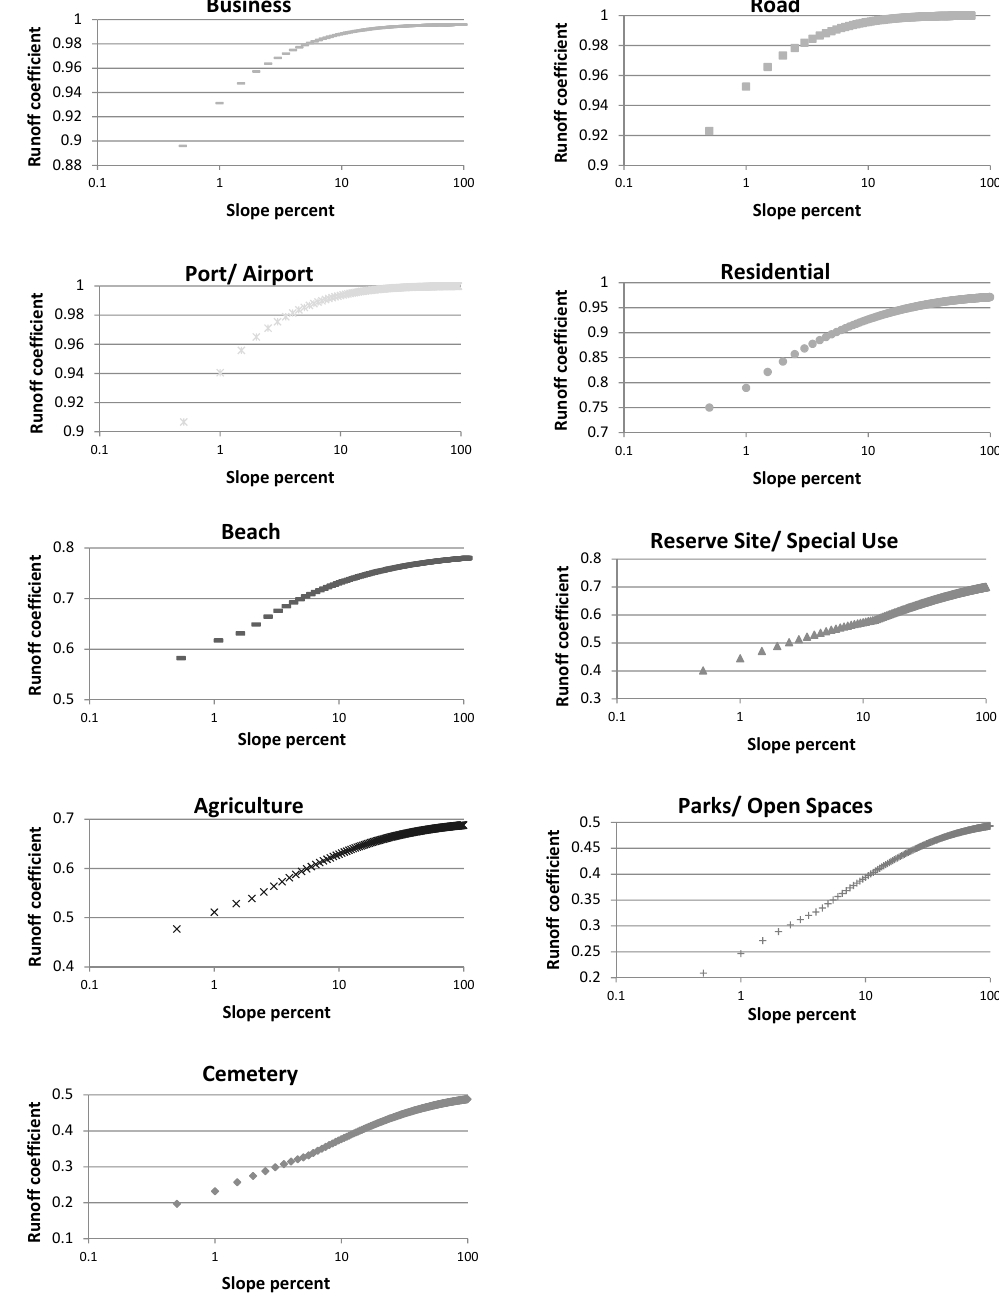
Figure 10. Runoff coefficient vs. percent slope plots for different land uses in Singapore.